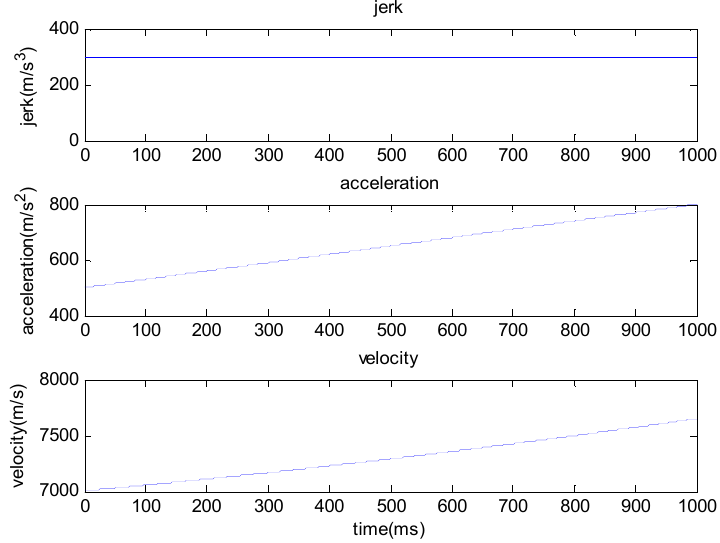
Figure 4. The high dynamic characteristics of simulated signal (line-of-sight